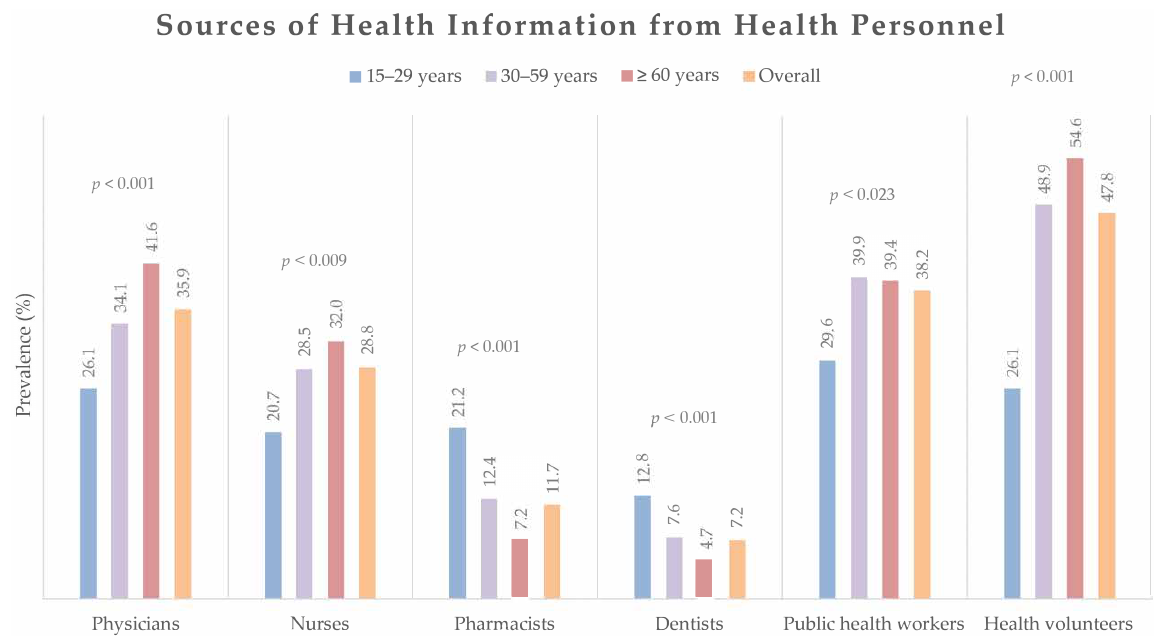
Figure 2. Sources of health information obtained from health personnel by participants overall and by age group. The differences in prevalence of received health information from health personnel among age-groups were analyzed by chi-square test.